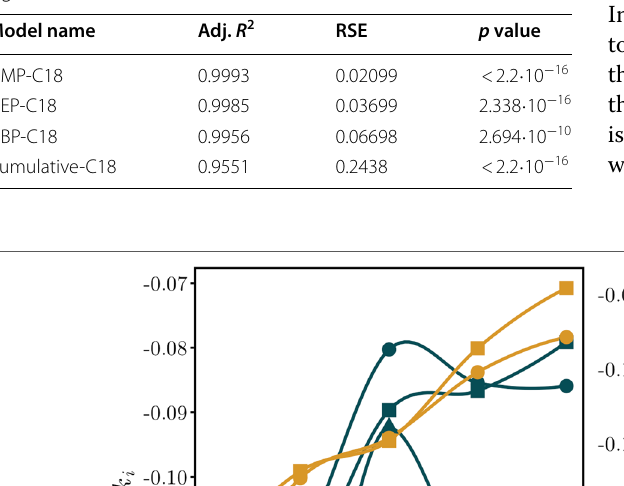
Table 4 Results of the statistical analysis of the multiple linear regression model. p values below 0.05 denote a statistical significance of the whole model